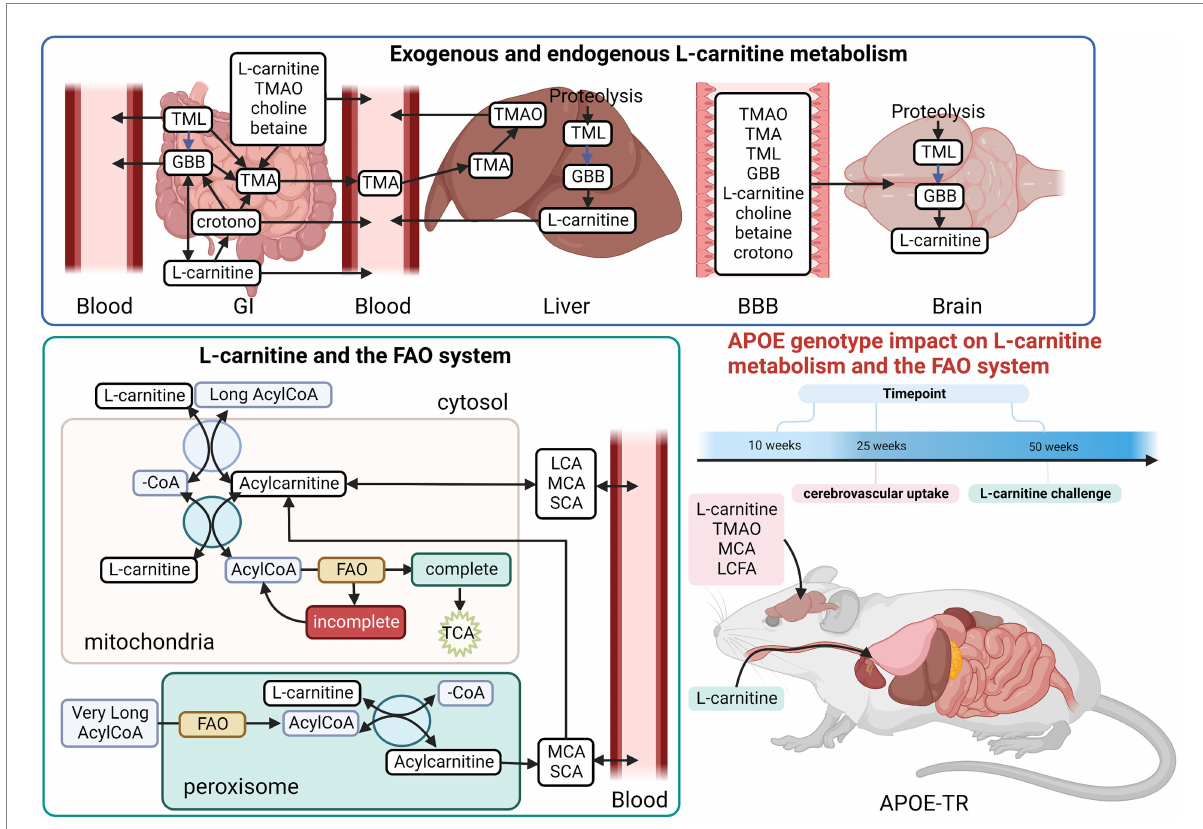
FIGURE 1 Overview of the L-carnitine system. Diagram showing an overview of the studies undertaken in the APOE-TR model. In the gut TMA-containing compounds obtained from the diet can be both directly absorbed into the blood and/or metabolized by the gut microbiome to yield TMA. Once in the bloodstream these metabolites enter tissues such as the liver and the brain. In the liver TMA is further oxidized to TMAO. Certain TMA containing compounds (TML, GBB, and L-carnitine) can also be biosynthesized by the liver and brain. Blue arrows in the L-carnitine biosynthesis pathways indicate some steps not shown. The exogenous and endogenous supplies of L-carnitine are important to the FAO pathway as activated long chain fatty acids (Long AcylCoA) can only enter the mitochondria through the L-carnitine shuttle system to undergo FAO. When there is an excess of intramitochondrial acyl-groups (during incomplete FAO) these can be exported out as acylcarnitines. The peroxisome also produces acylcarnitines from the chain shortening of activated very long chain fatty acids (Very Long AcylCoA). Here, we investigated the effect of APOE genotype and age on L-carnitine metabolite levels in the brain and the periphery. We also examined the effect of APOE on the cerebrovascular uptake of FAO-related compounds. Lastly, we interrogated the effect of APOE on the metabolism of exogenously supplied L-carnitine. BBB,